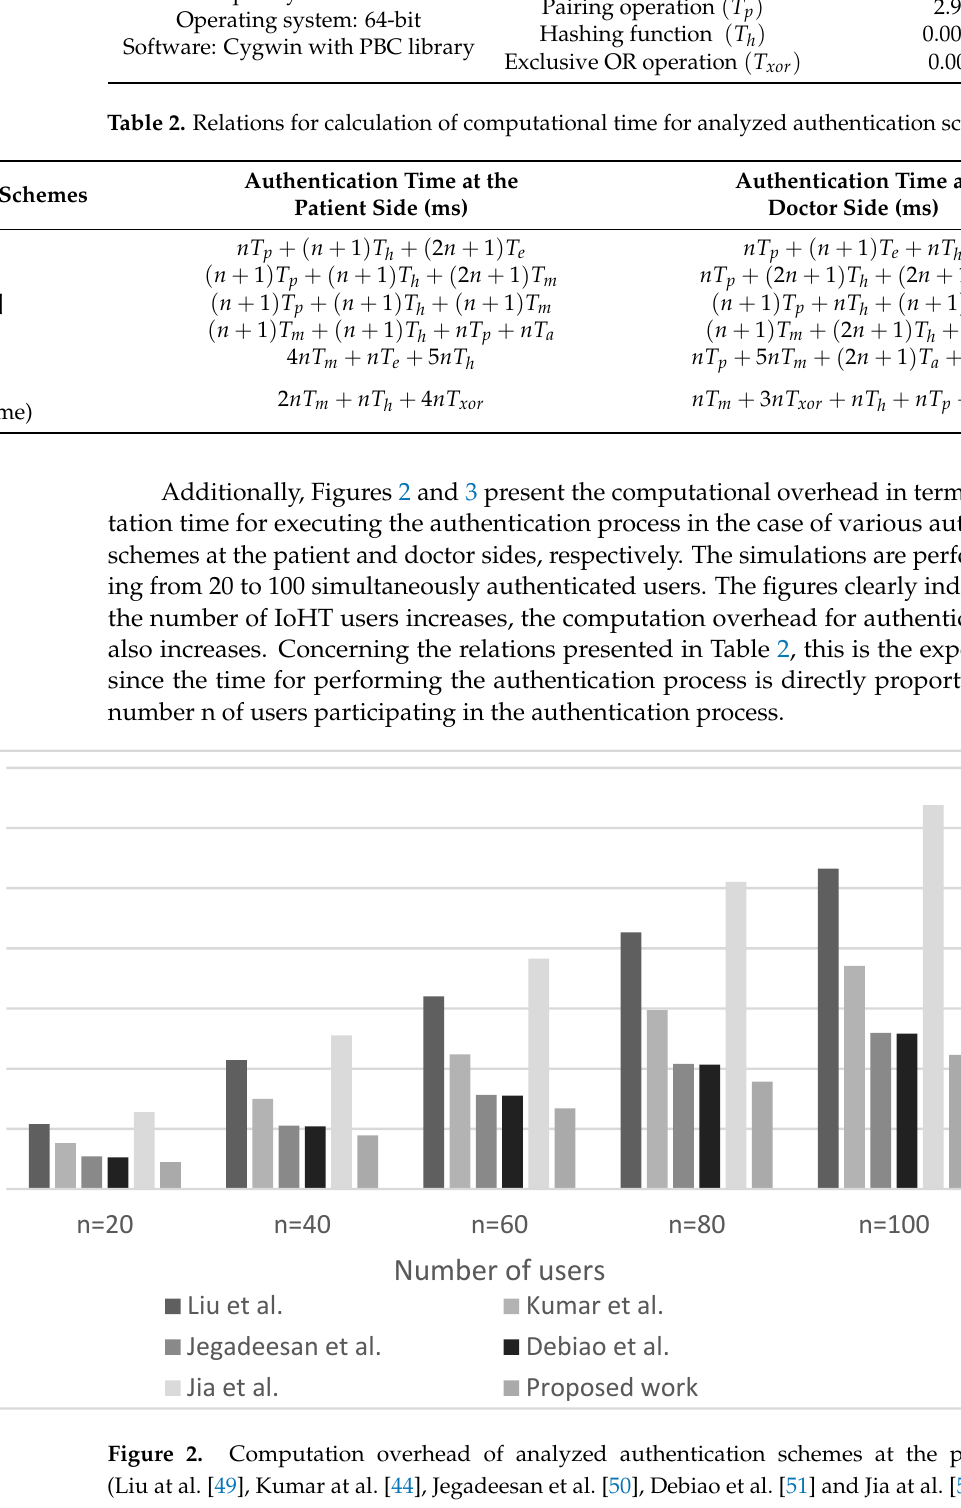
Table 2. Relations for calculation of computational time for analyzed authentication schemes.